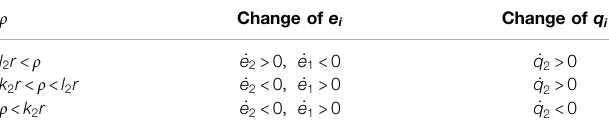
TABLE 3 | The behaviors of decentralized equilibrium with BB system. ρ Change of e i Change of q